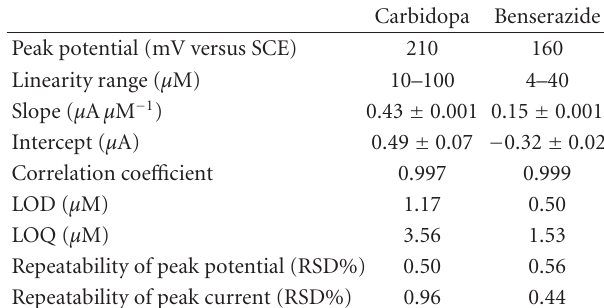
Table 1: Data from the calibration plots for the analytical char- acterisation of CD and BS in 0.1 M PBS, pH 5.0 by DPV at the MWCNTs/PNB-modified